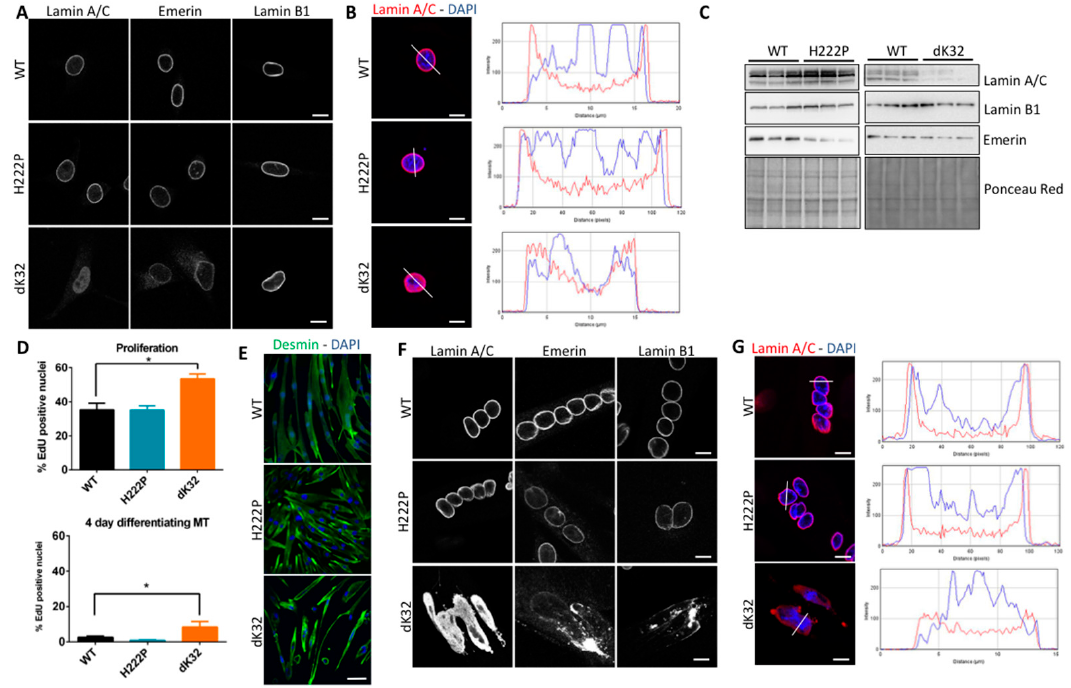
Figure 2. Phenotype of primary myoblasts derived from KI- Lmna H222P and KI- Lmna dK32 mouse models. ( A ) Confocal images of mouse primary myoblasts from control (WT), KI- Lmna H222P (H222P) and KI- Lmna K32del (dK32) mice showing immunostainings against Lamin A/C, Emerin and Lamin B1. Bar graph: 10 μ m. ( B ) Histogram showing pixel intensity for the Lamin A/C staining (red) and DAPI (blue) along the line traced on WT, H222P and dK32 nuclei of proliferating myoblasts shown on the left. Bar graph: 10 μ m. ( C ) Western blot analyses of control (WT), H222P and dK32 myoblasts showing expression level of Lamin A/C, Lamin B1, Emerin. Ponceau Red is used to assess homogeneity in total protein loaded. ( D ) Histogram showing the percentage of EdU positive nuclei in WT, H222P and dK32 proliferating myoblasts (top panel) and in four-day differentiating myotubes (lower panel) performed on at least three different experiments. *: p < 0.05 between H222P and dK32 myotubes. ( E ) Confocal images showing four-day differentiating control (WT), H222P and dK32 mouse primary myotubes stained with anti-Desmin antibody (green) and DAPI (blue). Bar graph: 50 μ m. ( F ) Confocal images of WT, H222P and dK32 mouse myotubes showing immunostainings against Lamin A/C, Emerin and Lamin B1. Bar graph: 10 μ m. ( G ) Histogram showing pixel intensity for the Lamin A/C staining (red) and DAPI (blue) along the line traced on WT, H222P and dK32 nuclei of differentiating myotubes shown on the left. Bar graph: 10 μ m.